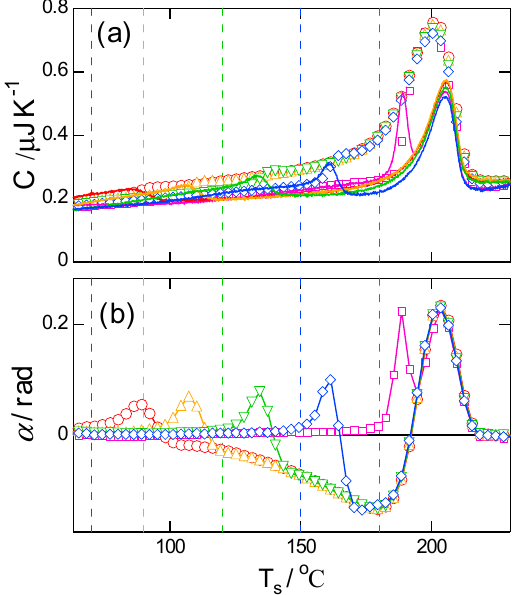
Figure 7. T-M FSC results of ( a ) magnitude and ( b ) phase angle during heating after crystallization at T c = 70 ◦ C for ∆ t c = 5 s and annealing of T a = NA, 90, 120, 150, 180 ◦ C for ∆ t a = 5 s. β = ∆ T 0 / P = 100 K s − 1 with ∆ T 0 = 9 K, P = 0.09 s. The solid lines in ( a ) represent − HF/ β , and the vertical broken lines represent respective treating temperatures.